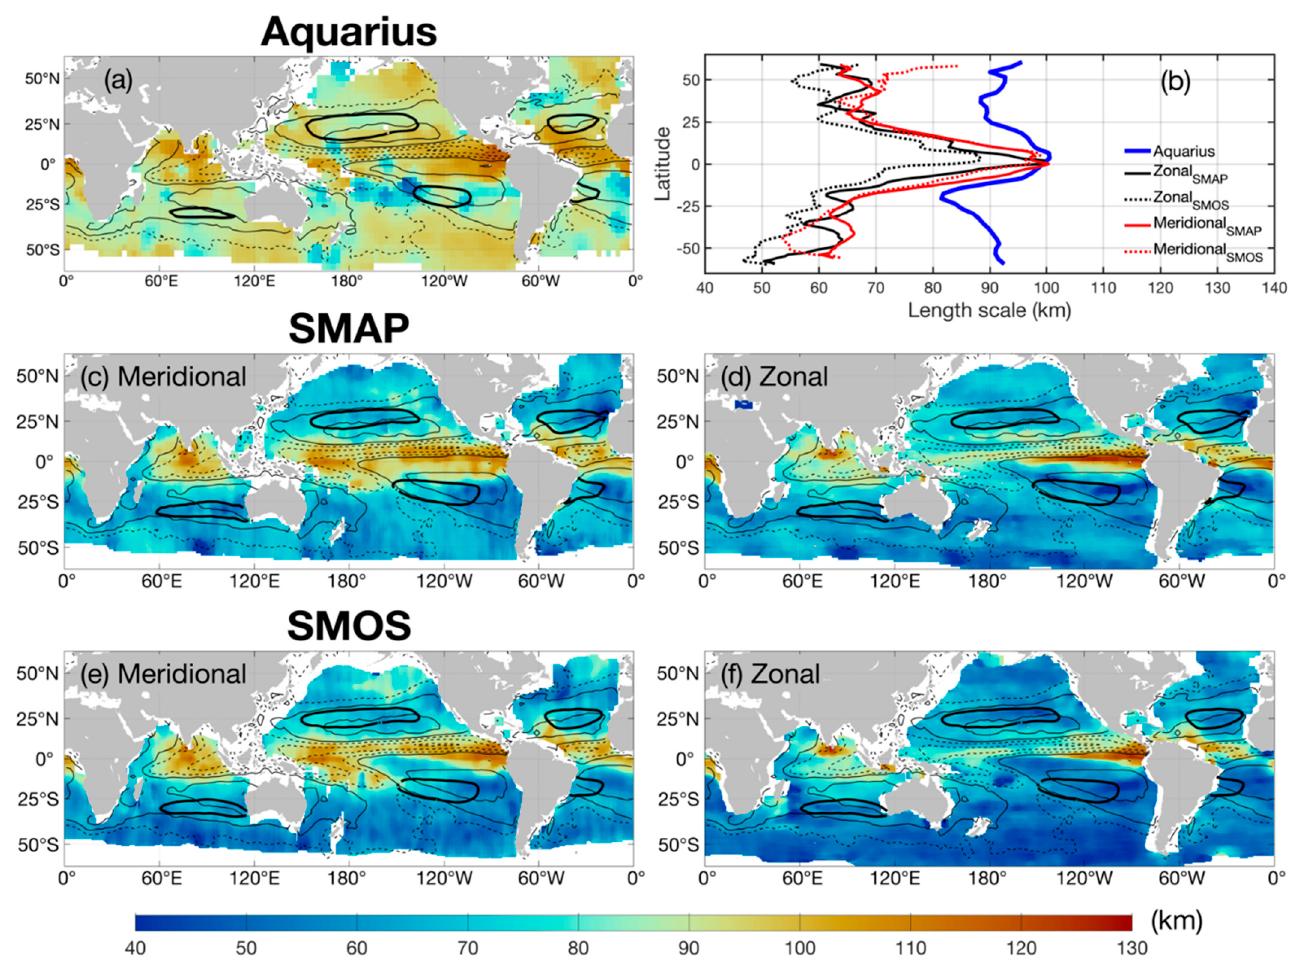
Figure 5. Spatial scales of SSS variability without the annual cycle, as in Figure 4.